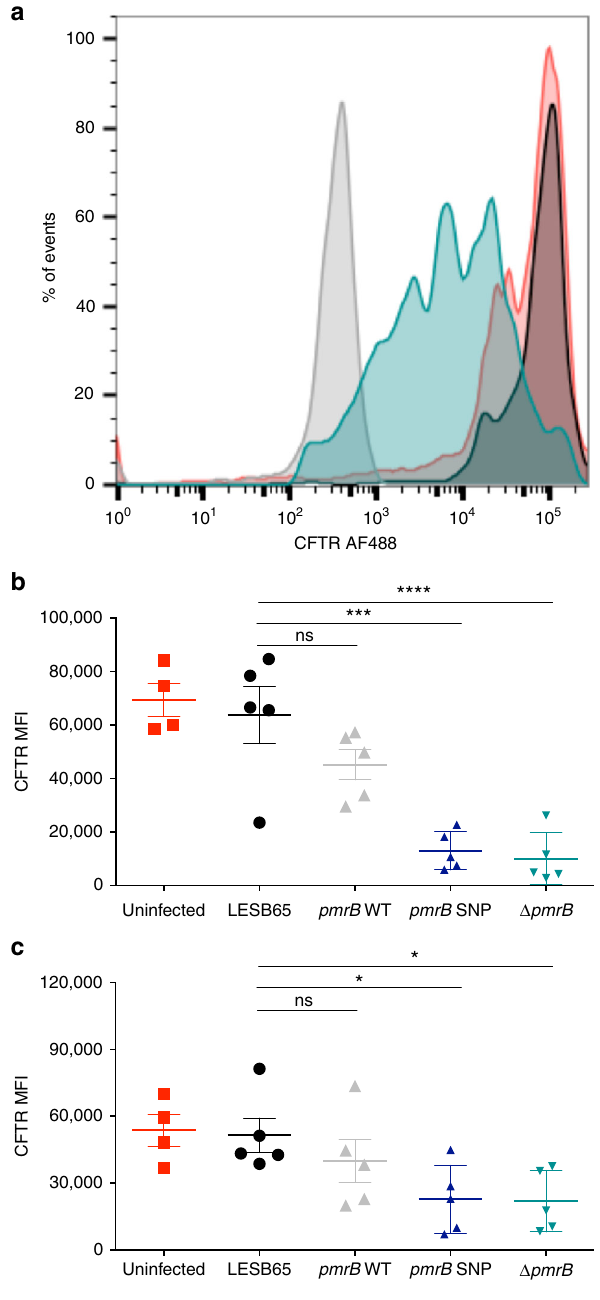
Fig. 3 Δ pmrB downregulates CFTR expression on airway epithelial cells. a CFTR expression on uninfected (red), LESB65 infected (black) and Δ pmrB infected (blue) A549 airway epithelial cells as measured by fl ow cytometry and compared to isotype control staining (grey). CFTR alexa fl uor 488 median fl uorescent intensity (MFI) on stained ( b ) A549 and ( c ) Detroit cells. Data in ( b ) are a composite of two independent experiments with two-three biological replicates per condition in each experiment. Data in ( c ) are from a single experiment containing 4 biological replicates. Asterisks (*) represent signi fi cant differences in one-way ANOVA with Dunnett ’ s multiple comparison test. * p < 0.05, *** p < 0.001, **** p <